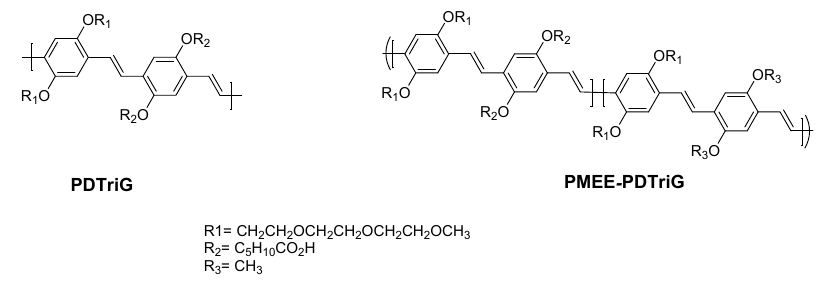
Figure 2. Structures of the polymers: PDTriG and PMEE-PDTriG.